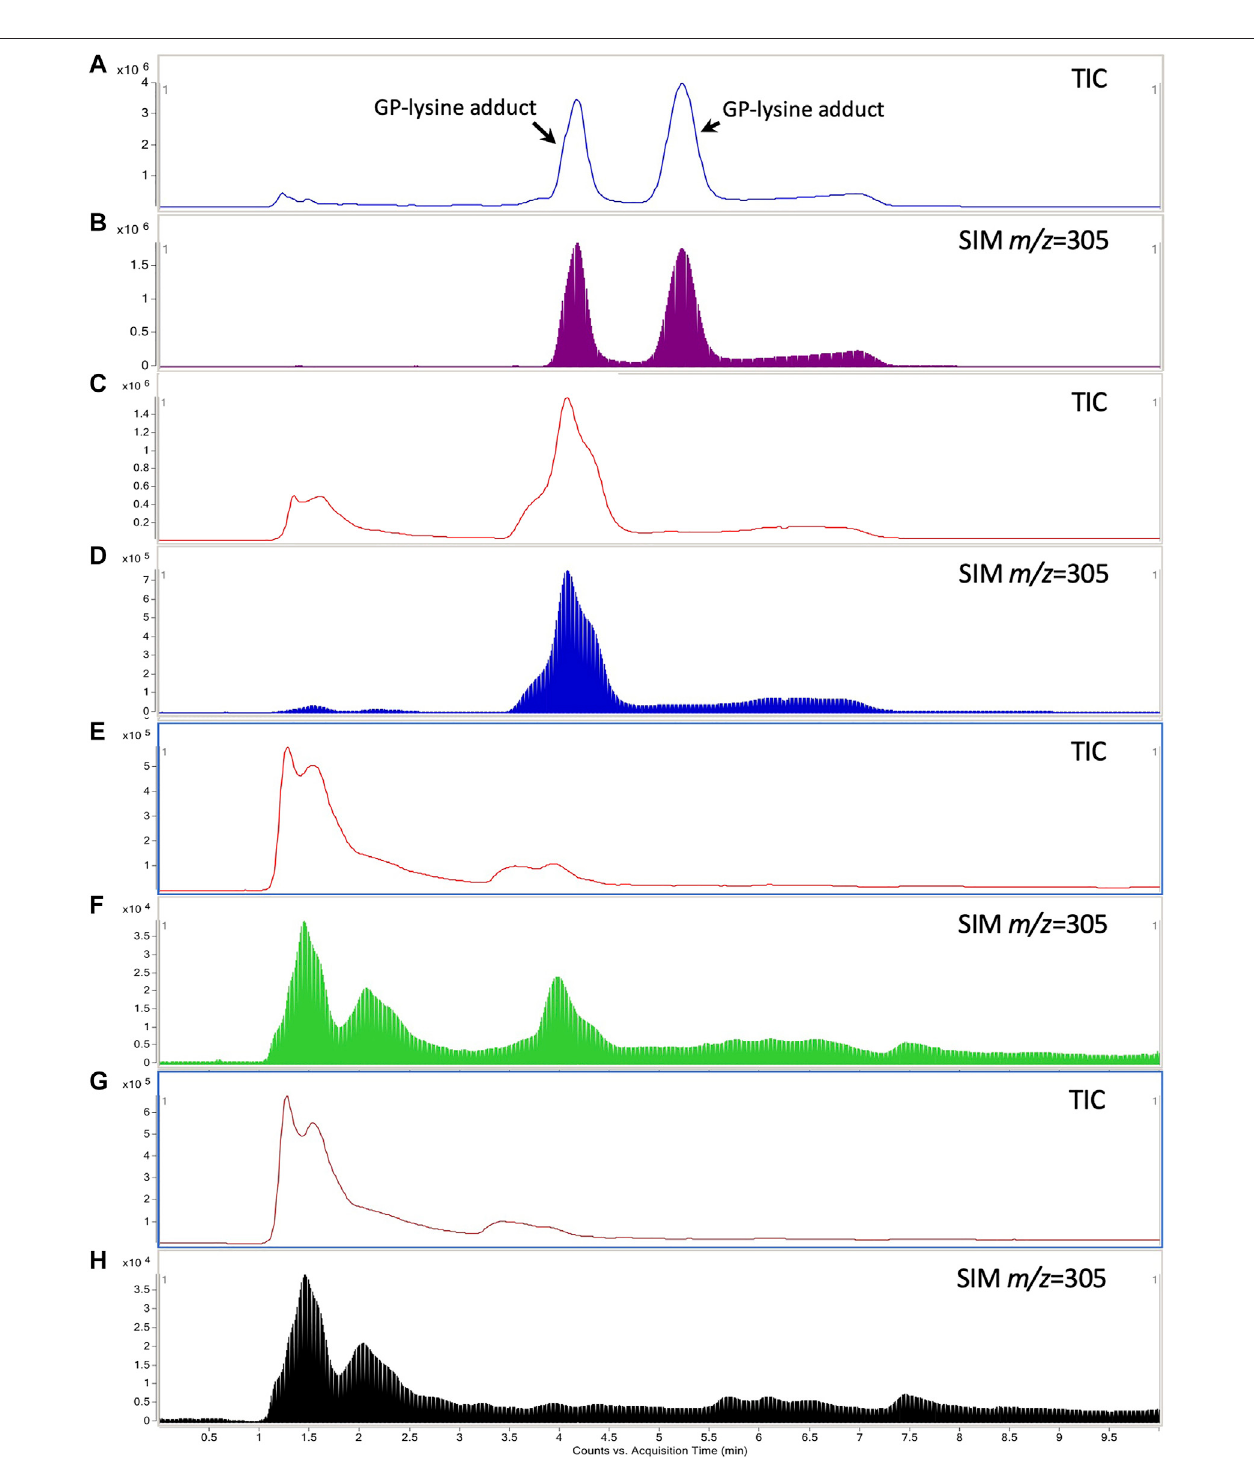
FIGURE 7 | Typical total ion chromatogram (TIC) and extracted ion chromatography ( m/z (cid:1) 305) of the GP-lysine adduct in the incubation mixture of 10 mM L- lysine with 1 mM GP (A, B) , mixture of blank liver homogenate with 1 mM GP after incubation (C, D) , liver homogenate of healthy rat which received two-week coadministration of SV and GJ (E, F) , and liver homogenate of healthy rat which received two-week administration of GJ (G, H) .